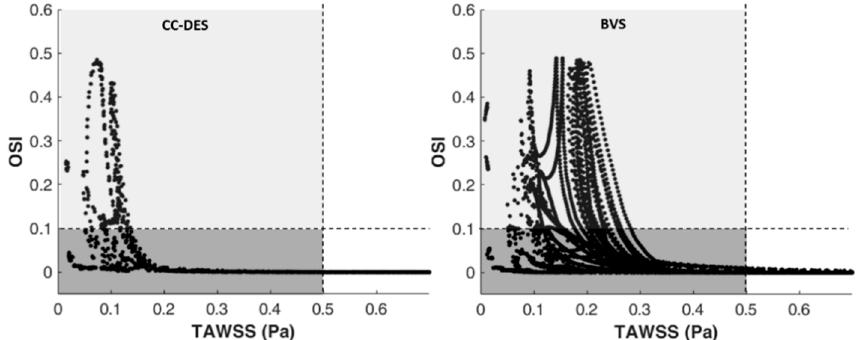
Figure 7. OSI vs. TAWSS plots. Each point represents a nodal solution of the arterial wall. The considered configurations were MD = 40, 60 and 80 µm for CC-DES stent and MD = 40, 80, 115, 150 and 180 µm for BVS stent.